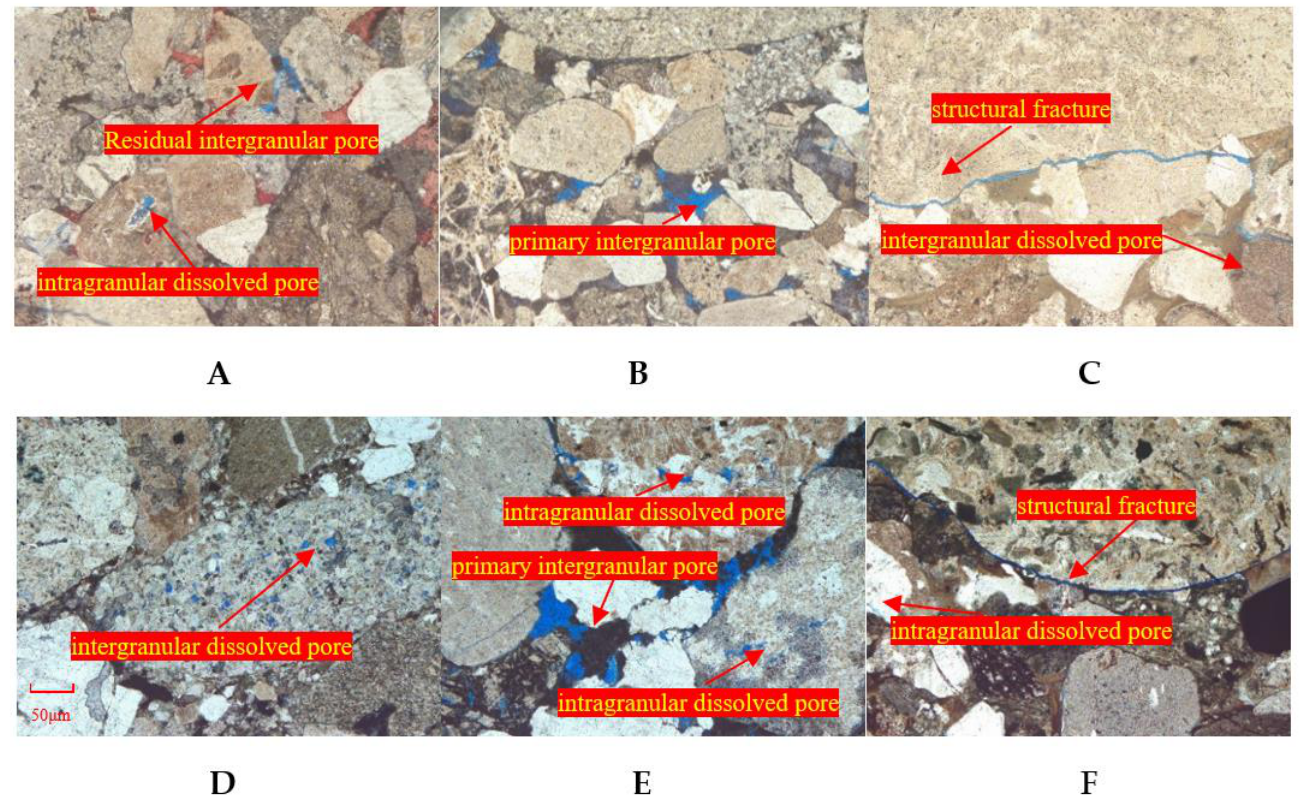
Figure 4. Images of thin sections showing the morphology of the pore throats. ( A ) M154, 3024.39 m, sandy conglomerate; ( B ) M154, 3027.85 m, fine-grained conglomerate; ( C ) M154, 3070.74 m, conglomerate with large pebbles; ( D ) X89, 2231.26 m, pebbly sandstone; ( E ) X89, 2284.55 m, conglomerate with small pebbles; ( F ) X89, 2474.21 m, conglomerate with medium pebbles.